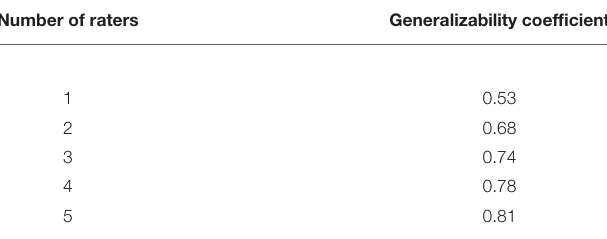
TABLE 4 | D-study generalizability